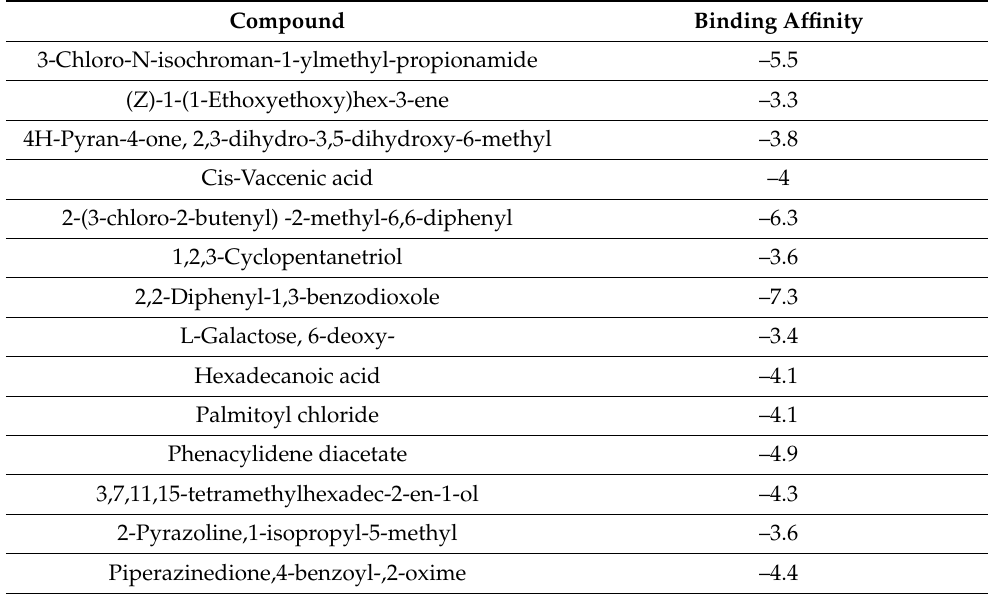
Table 10. Docking score of MAGE-A protein with selected